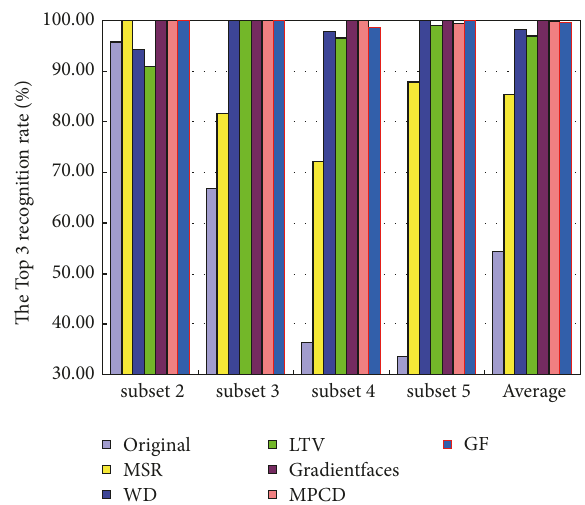
Figure 6: Comparisons on the Top 3 recognition rate (the subset 1 used as the training set).